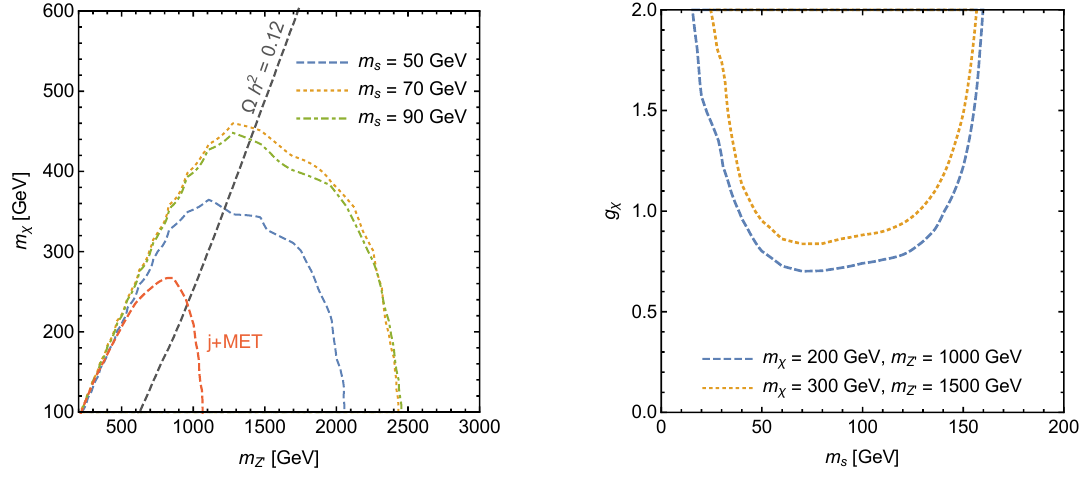
Figure 5 . Left: expected sensitivity of a mono-dark-Higgs search with an integrated luminosity of 40 fb (cid:0) 1 , considering events with =E > 500 GeV and using a CL s method to compare the m J - T distribution for signal and background. Dashed, dotted and dash-dotted lines correspond to m s = 50 GeV, m s = 70 GeV and m s = 90 GeV, respectively. For comparison, we show the expected sensitivity of a conventional mono-jet search and the parameter combinations for which the observed relic abundance is reproduced. Right: bound on the dark sector coupling g (cid:31) as a function of the dark Higgs mass m s for two di(cid:11)erent benchmark